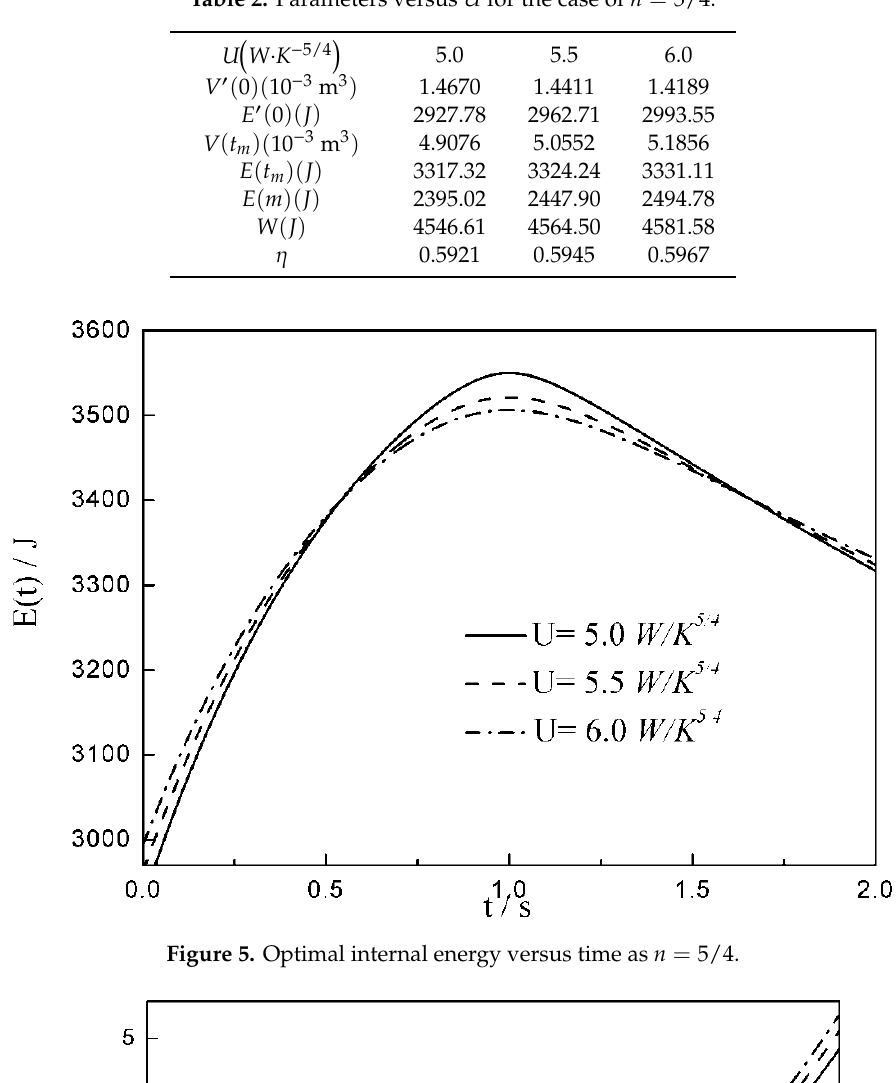
Table 2. Parameters versus U for the case of n = 5/4.